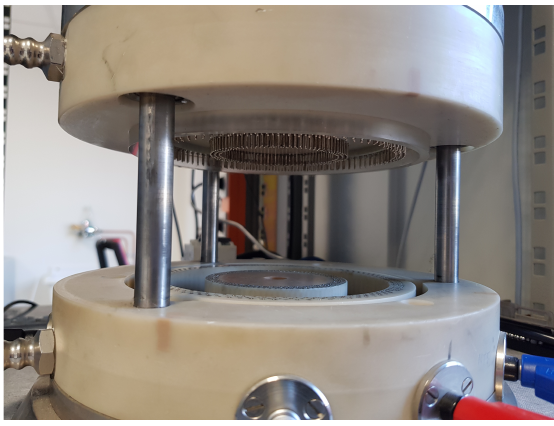
Figure 1. The split-coil